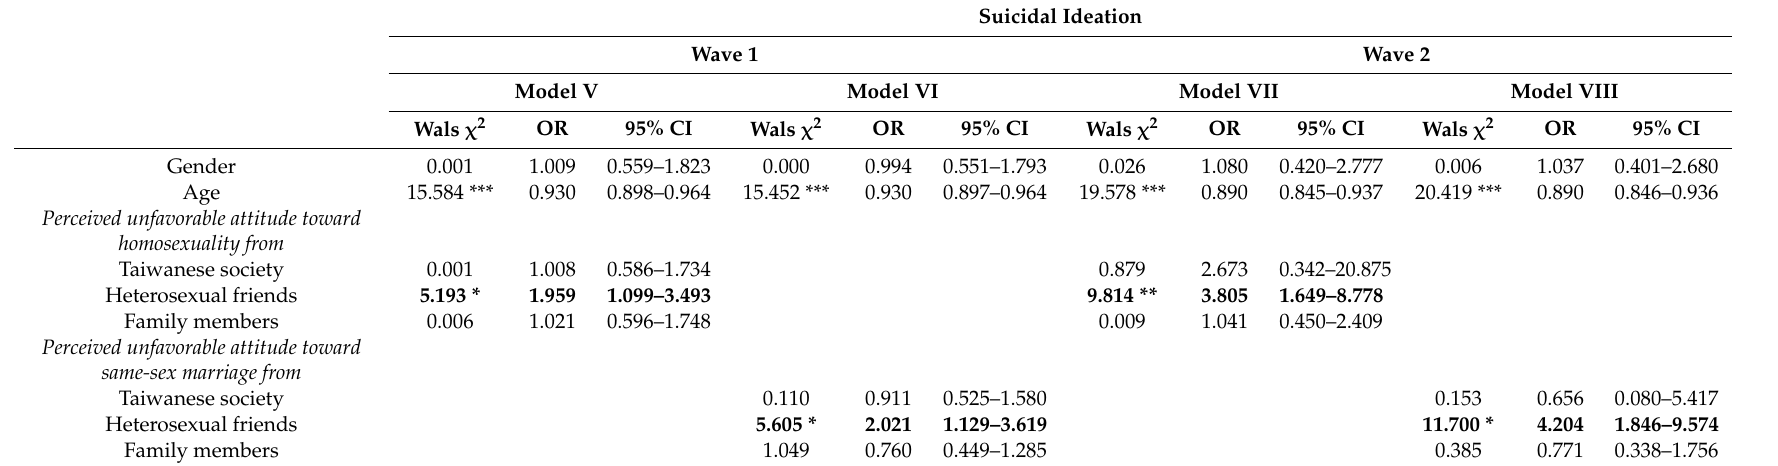
Table 3. Association of perceived unfavorable attitudes toward homosexuality and same-sex marriage from Taiwanese society, heterosexual friends, and family members with suicidal ideation in heterosexual